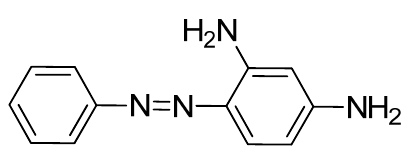
Figure 1. Structure of